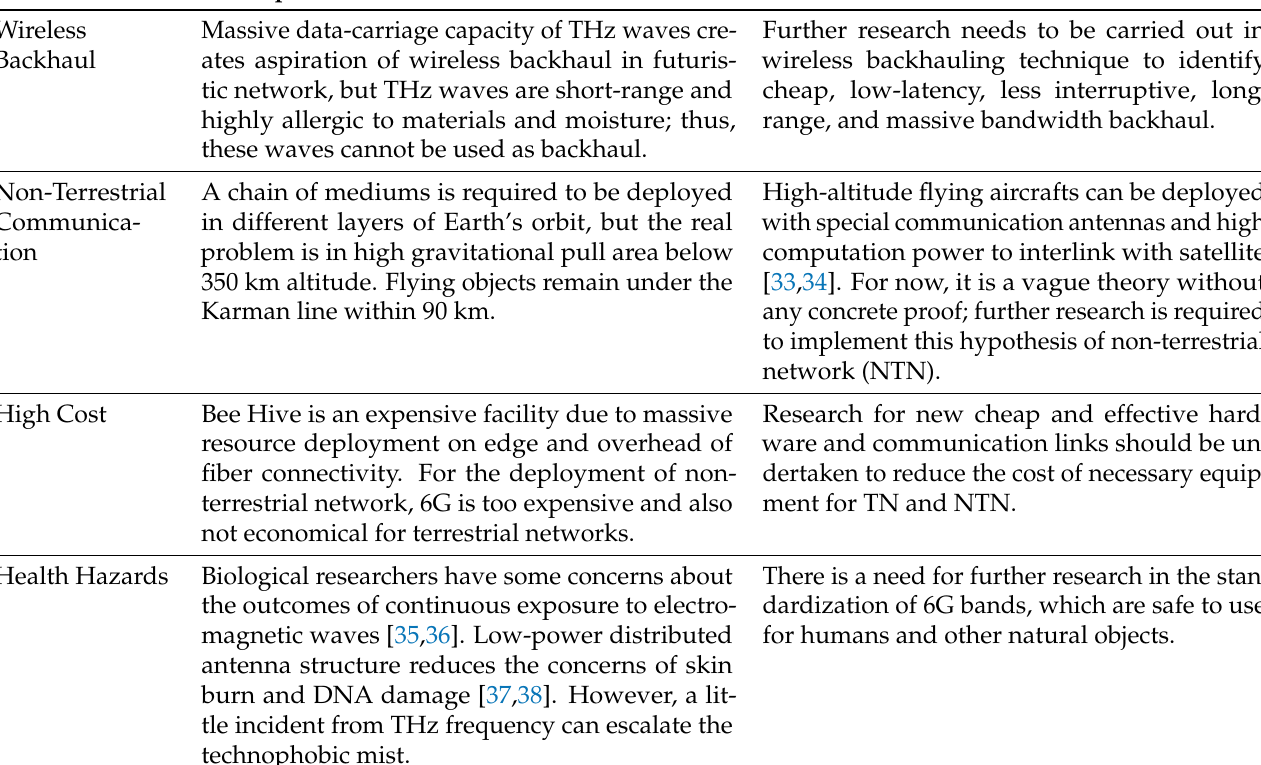
Table 1. Obstacles for 6G and Bee